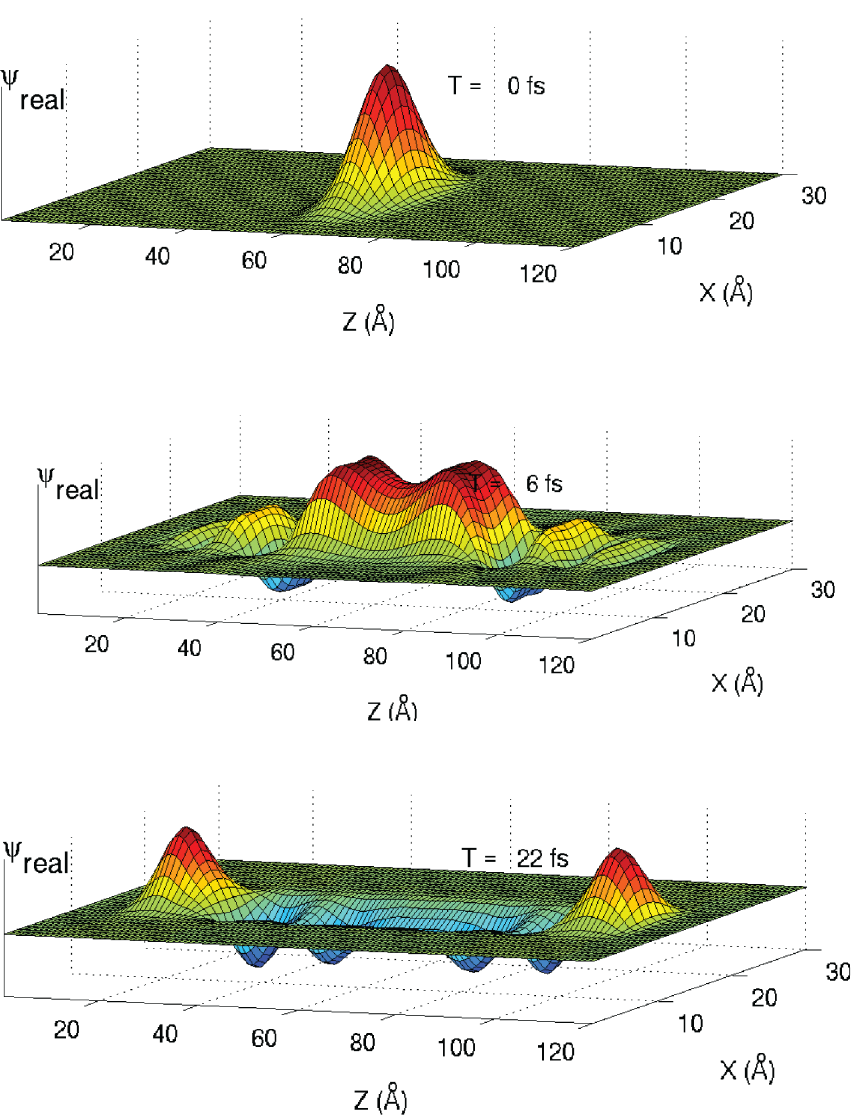
Fig 4. A test function is initialized in the problems space. As the FDTD simulation proceeds, the waveform spreads